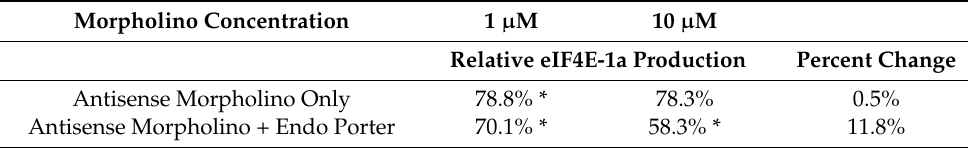
* Significant difference when compared to the control based on a p -value of < 0.05. Interestingly, we also found that expression levels became relatively similar after 96 h, showing the temporary effects of the morpholino (Supplemental Figure